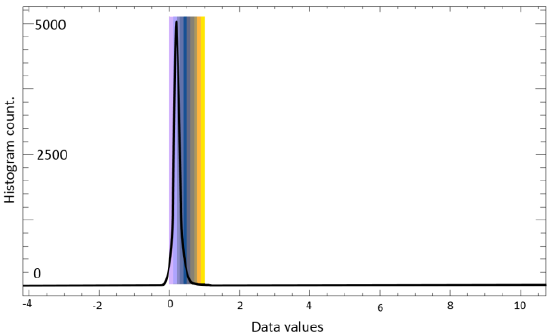
Figure 9. Histogram of burned peat fraction derived from PCA spectral using local